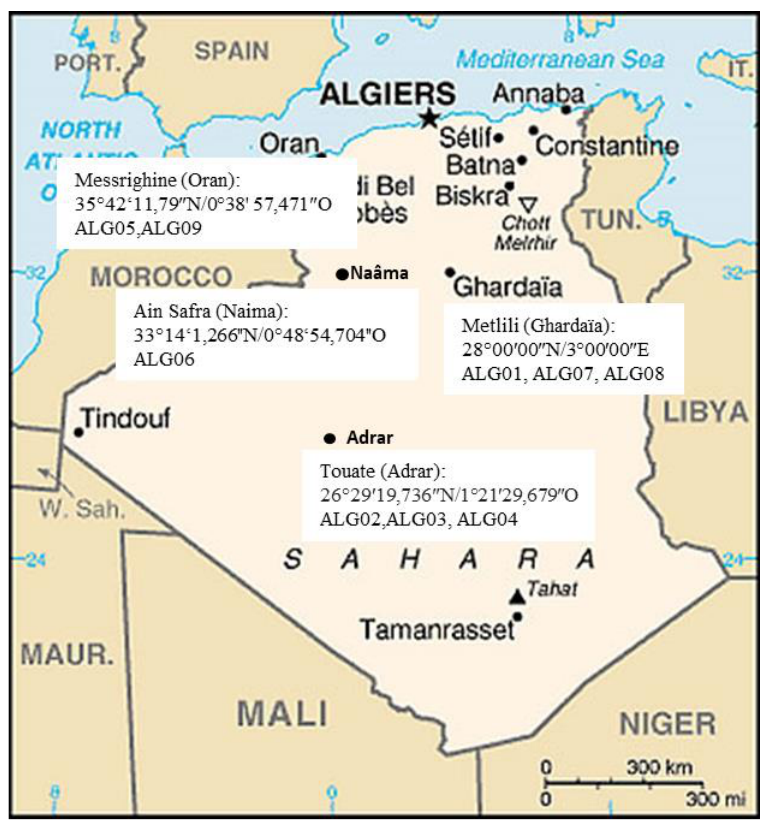
Figure 1. Map of Algeria showing sampling regions of Trichoderma isolates during 2015–2016 Figure1. MapofAlgeriashowingsamplingregionsof Trichoderma isolatesduring2015–2016(Illustration (Illustration source: https//www.google.dz/maps). source: https // www.google.dz /